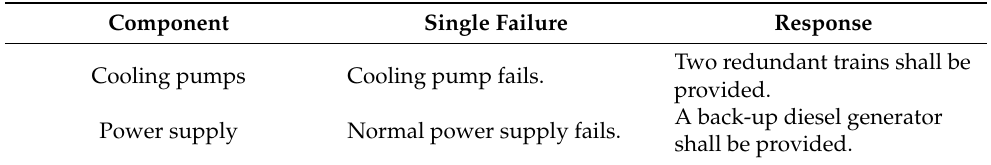
Table 9. Applicable single failure cases.